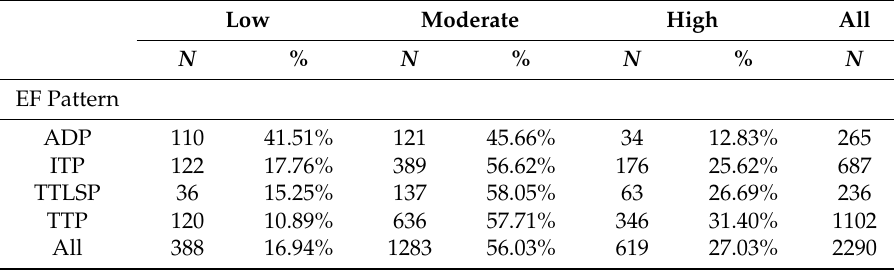
Table 3. Differences in nutrition knowledge distribution among EF patterns.